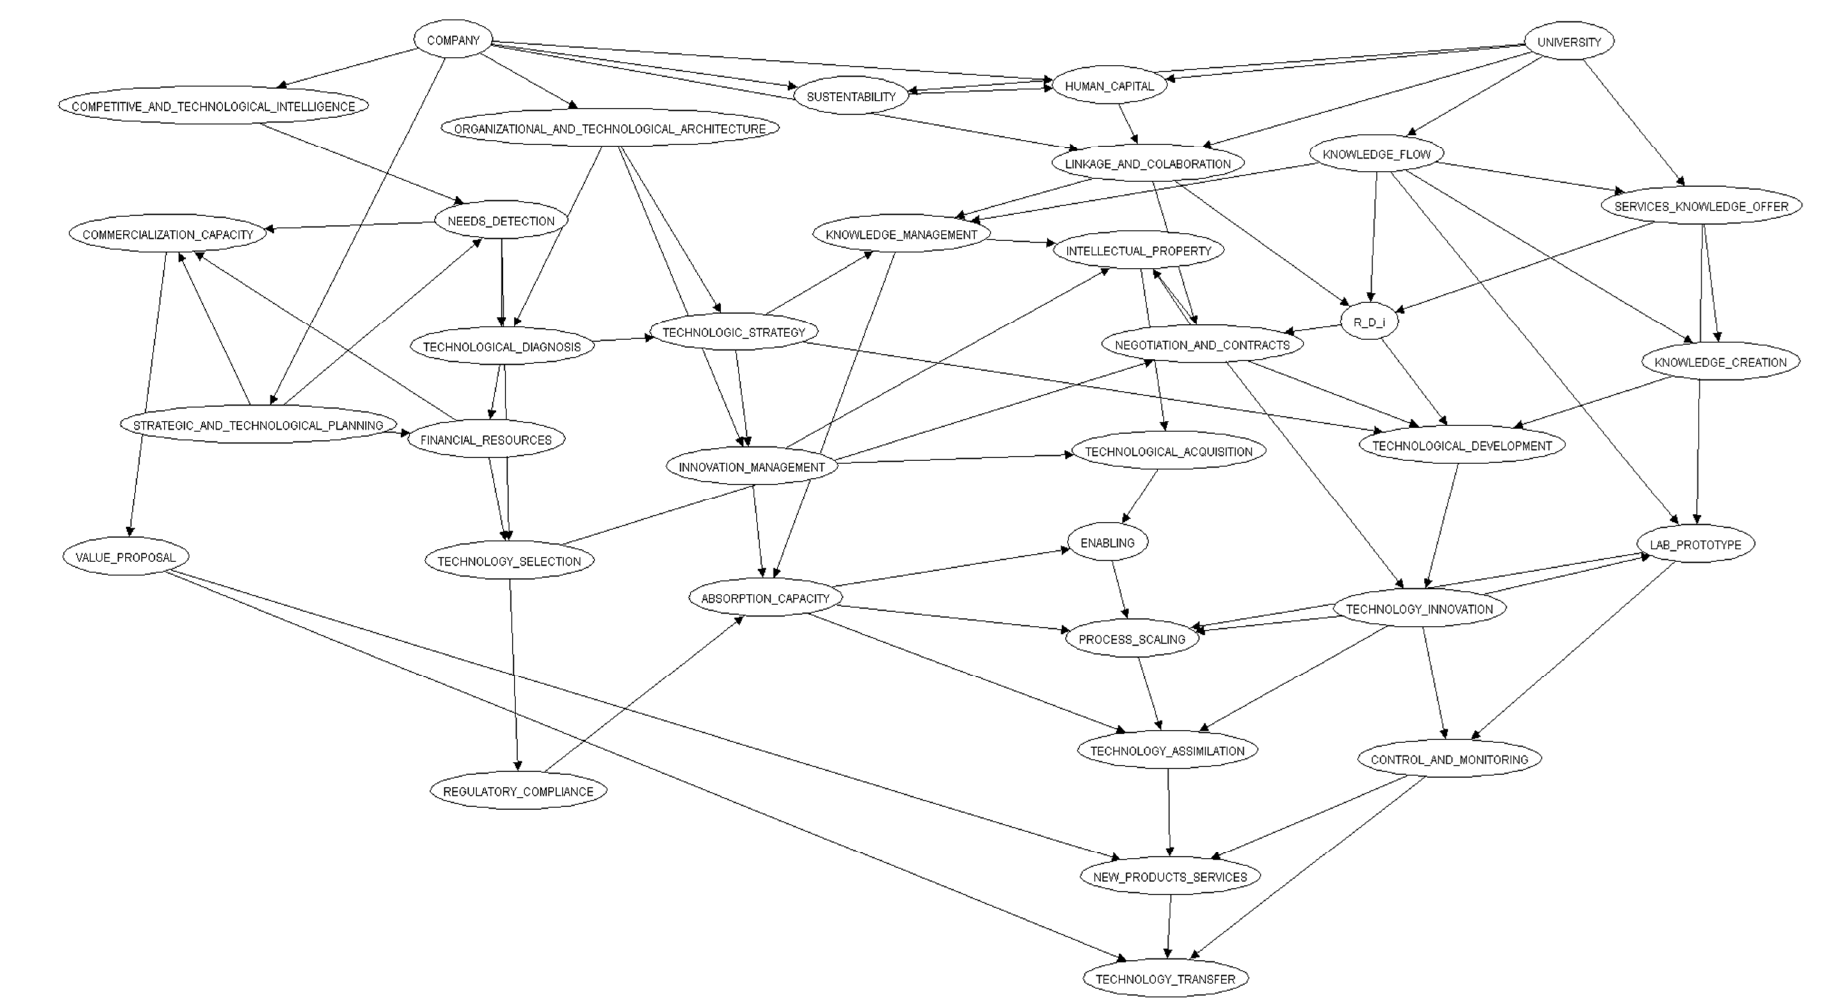
Figure 1. University–enterprise linkage as a sustainable technology transfer model.